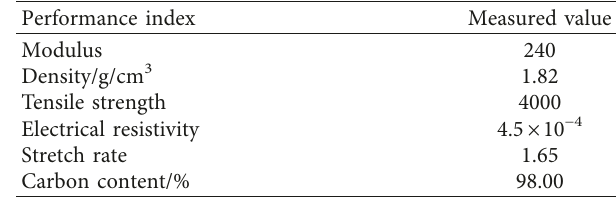
Table 3: Technical indexes of carbon fiber. Table 1: Main performance of